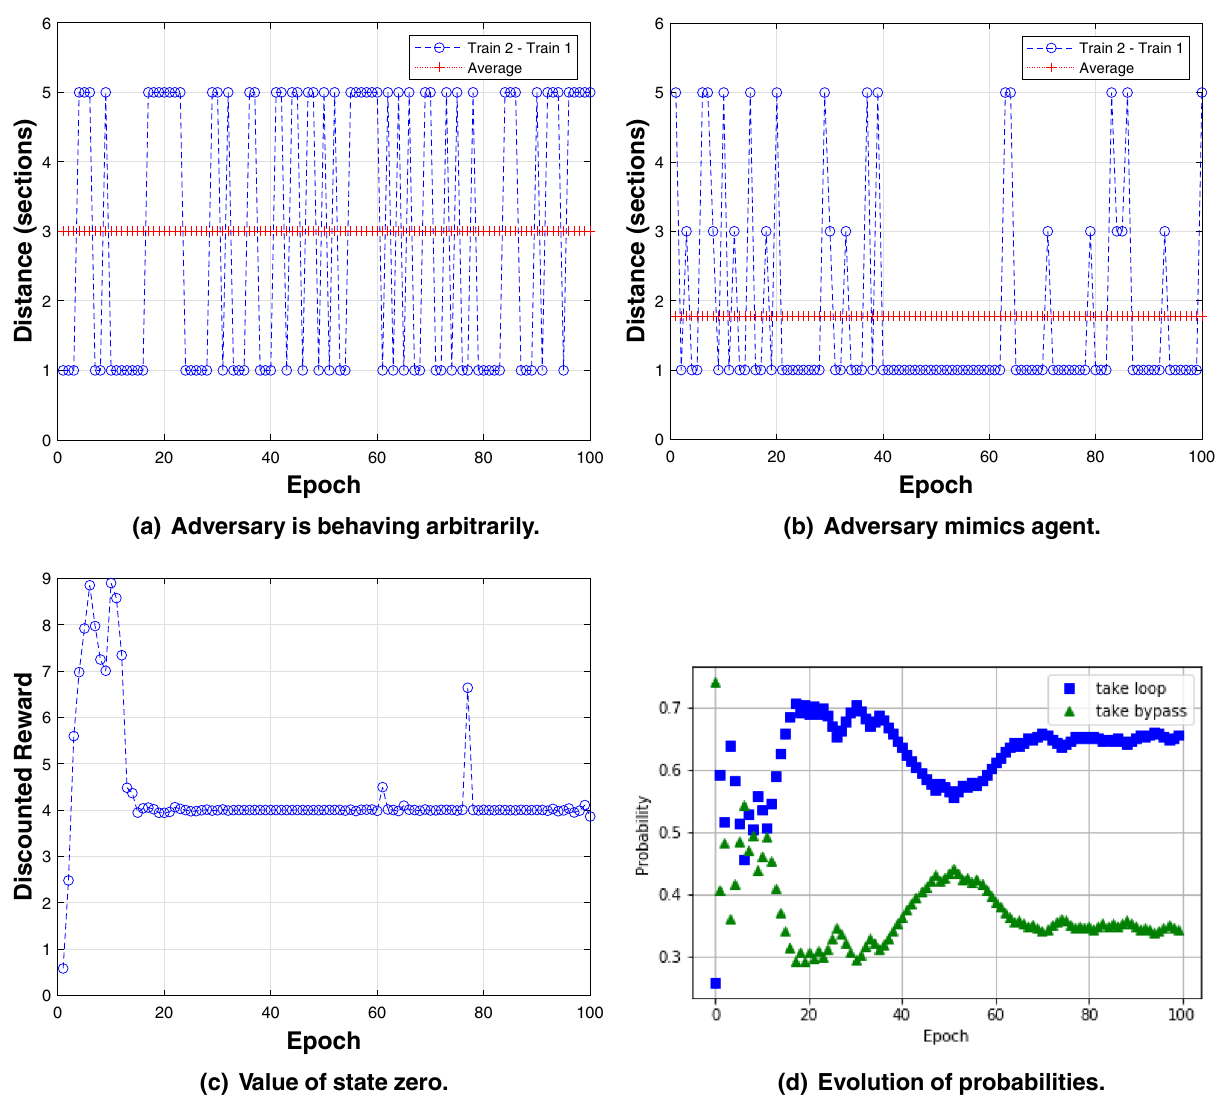
Figure 7. ( a ) The adversary randomly alternates between take loop and take bypass, with equal probabilities. ( b ) The agent choices are leaked, e.g., due to the presence of an insider. With high probability, the adversary is mimicking the agent. ( c ) Evolution of the value of state zero. ( d ) Evolution of quantum variational circuit probabilities, with learning rate α equal to 0.01.